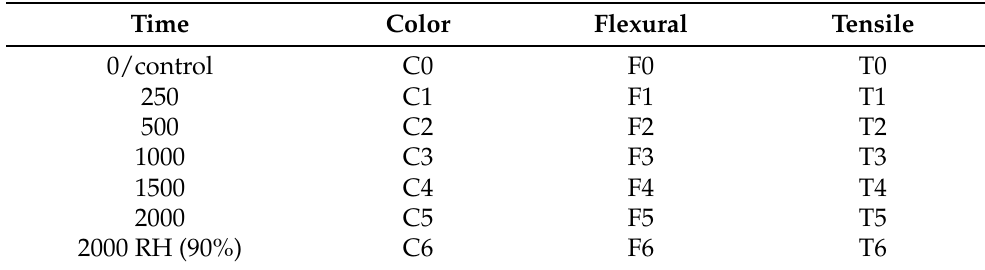
Table 2. Experimental sample distribution.